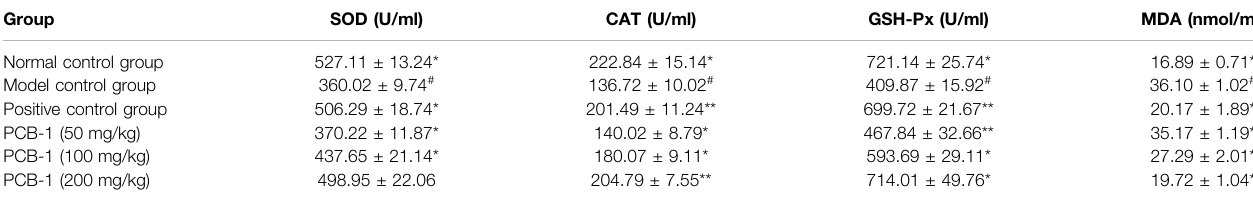
TABLE 1 | Effects of PCB-1 on activities of SOD, CAT, GSH-Px and levels of MDA in serum of D-gal induces oxidative damage mice. Group